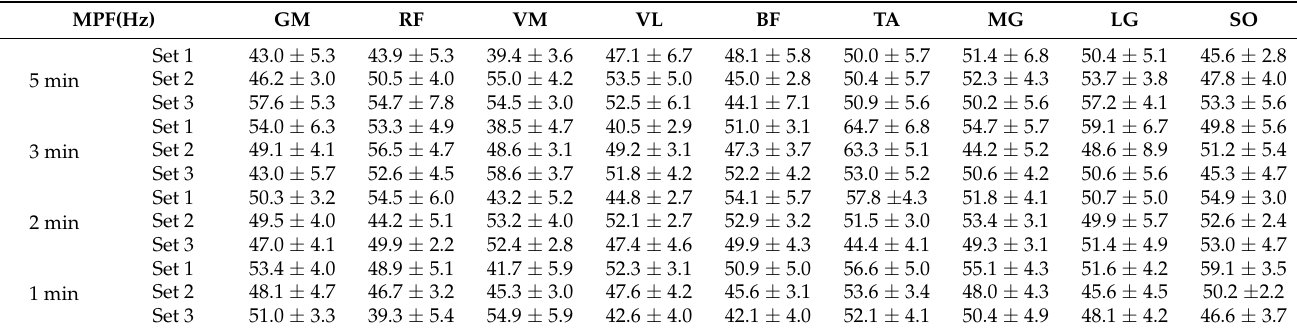
Table 4. EMG mean power frequency (MPF) of the 9 tested muscles at each set and